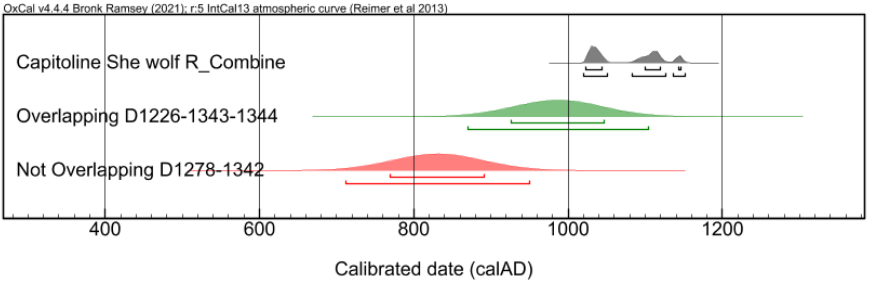
Figure 5. Comparison between the combined radiocarbon date ([7]) and the combination of the two sub-sets of TL dates.